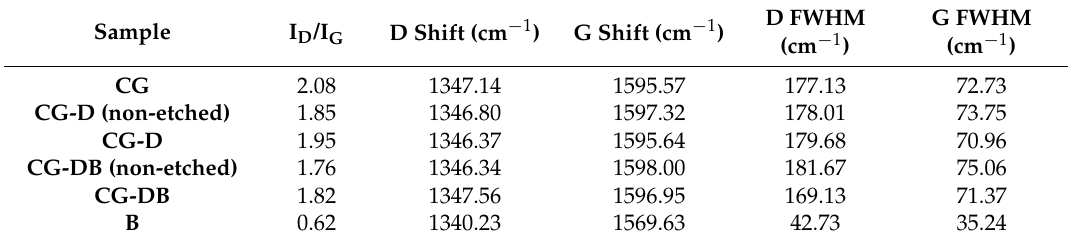
Table 2. Raman parameters (shift and Full Width at Half Maximum, FWHM) for the D and G bands calculated from the deconvoluted spectra.